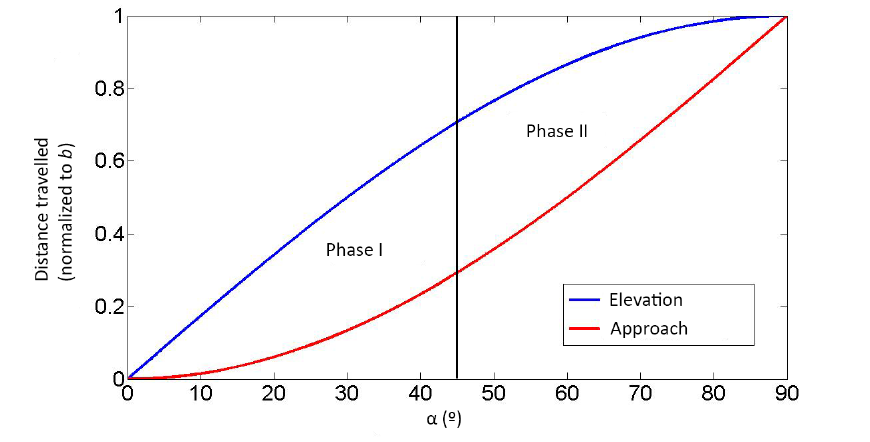
Figure 9. REMOVI mechanical